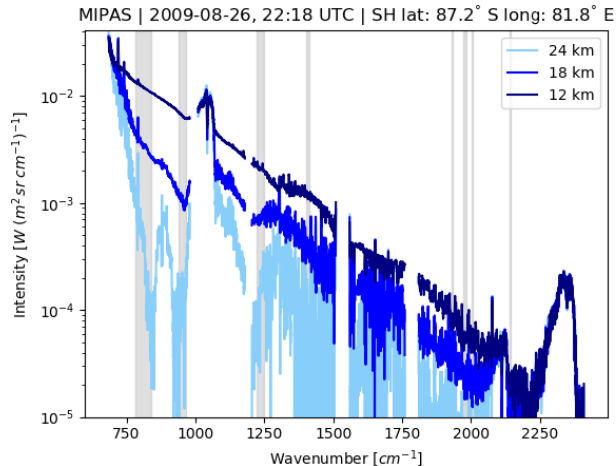
Table 1. Infrared spectral regions considered for PSC classification.